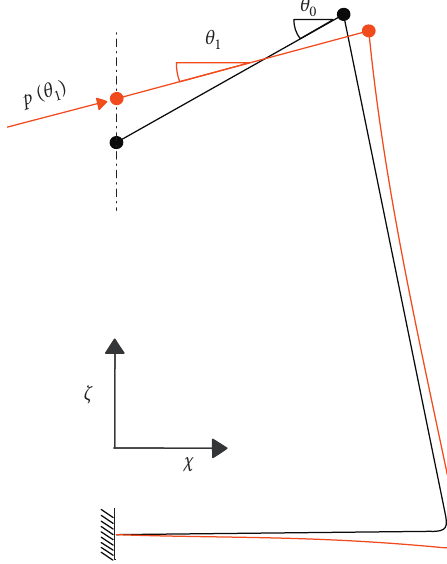
Figure 3: Model of the